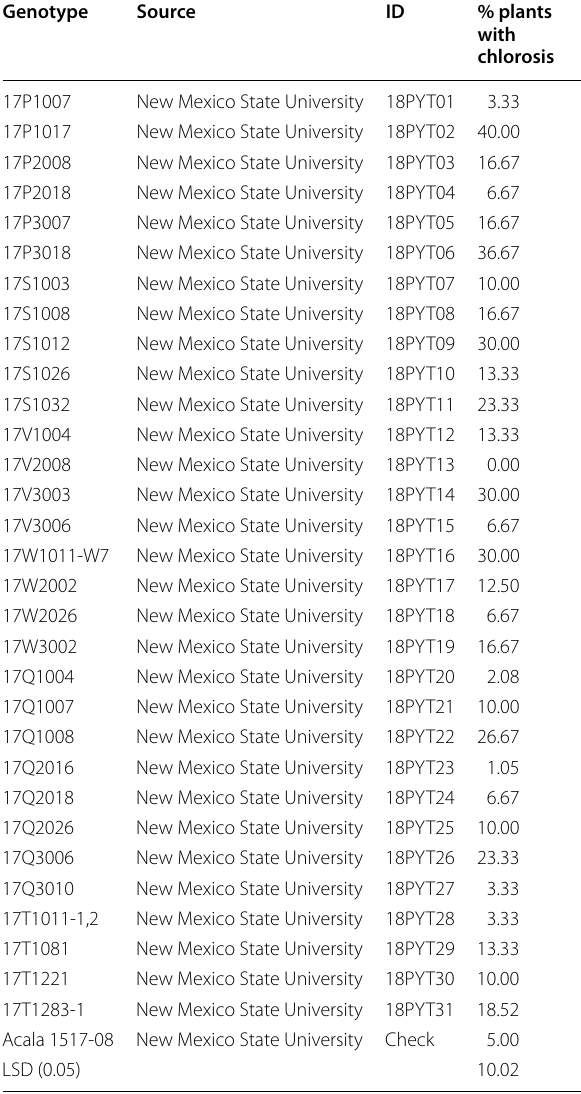
Table 5 Mean crop injury rating caused by herbicide trifloxysulfuron in test 18G with 32 Upland cotton genotypes, Las Cruces, NM, US, June 2018